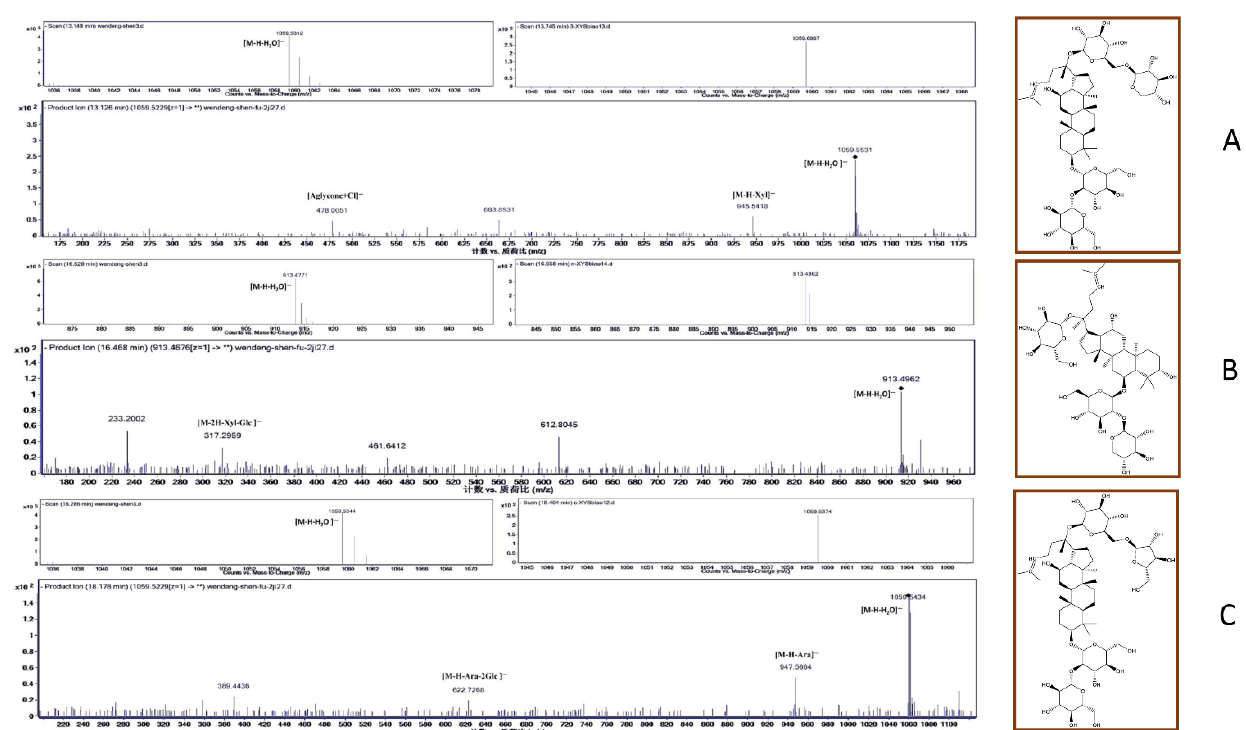
Figure 2. MS and MS/MS spectra of the biomarkers identified in P. quinquefolius from Wendeng: ( A ) ginsenoside Rb 3 ; ( B ) notoginsenoside R 1 ; ( C ) ginsenoside Rc.